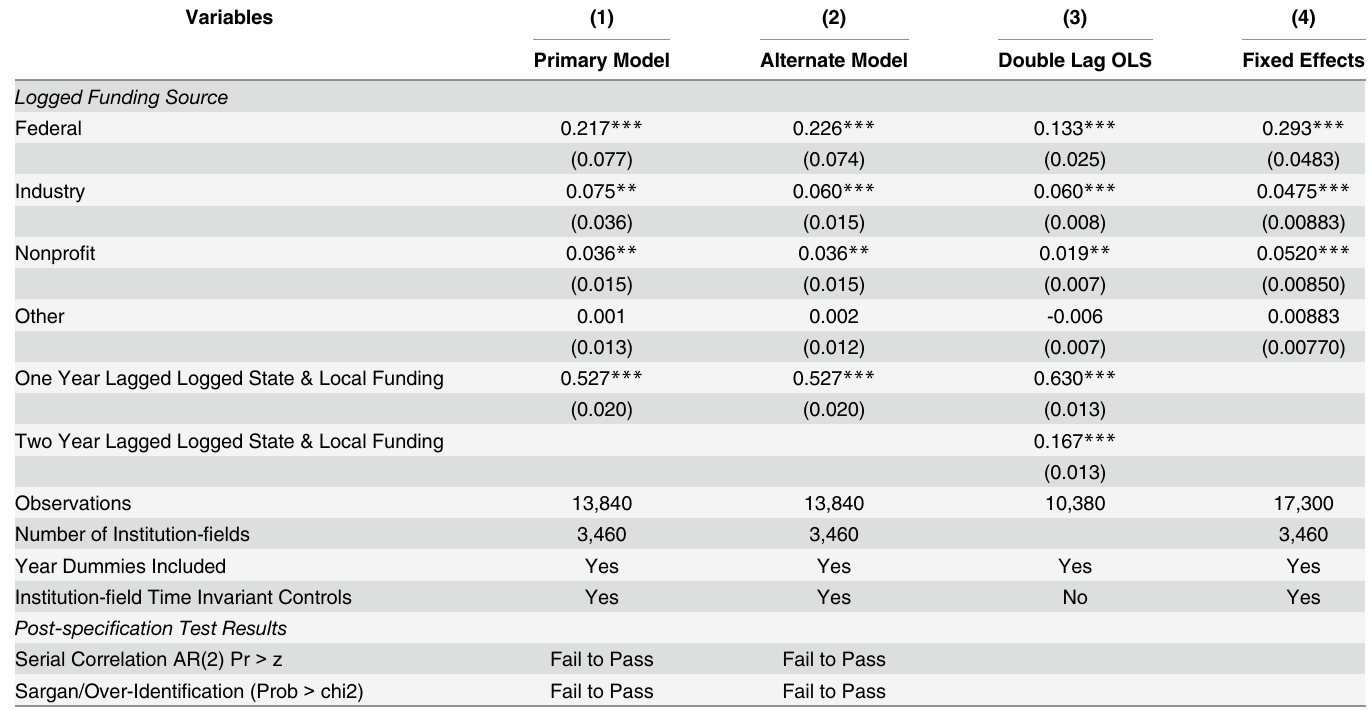
Table 4. State & Local R&D Log Expenditure Regression Results, Additional Model